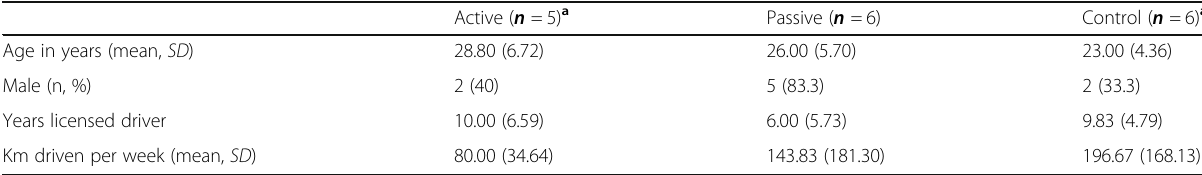
Table 1 Descriptive statistics of the three groups of